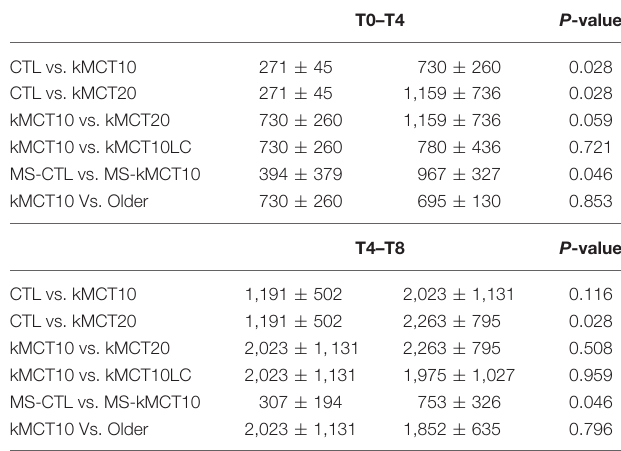
TABLE 4 | Areas-under-the-curve for total ketones ( µ mol h/L; β -hydroxybutyrate + acetoacetate) during the first 4h (T0–T4) or the second 4h (T4–T8) of the metabolic study days (see Table 1 for legend).